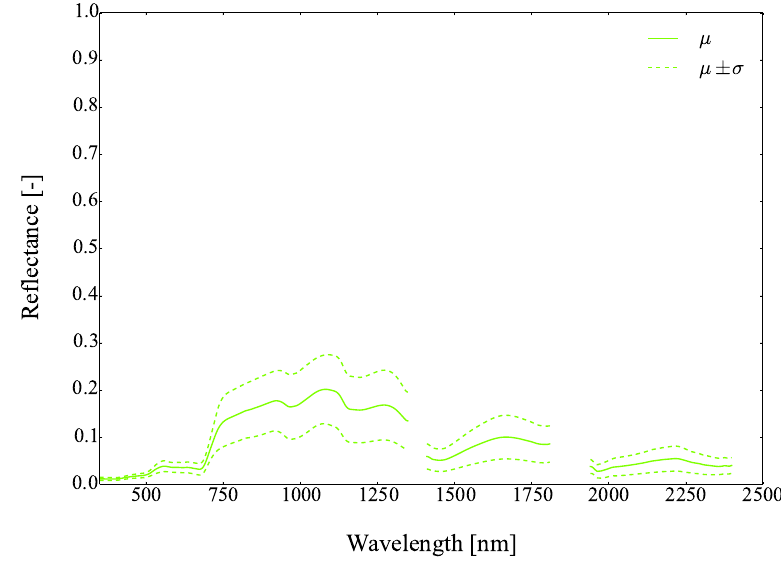
Figure A18. Mean reflectance ( µ ) and standard deviation ( σ ) of Aquatic type a